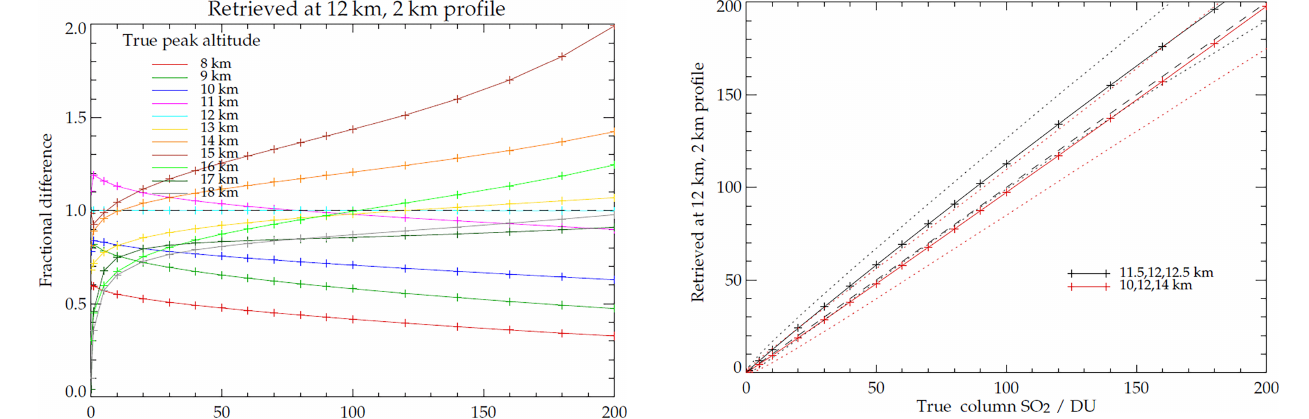
Figure 4. The black line indicates how columns from 0.1 to 200DU are retrieved on a fixed grid with a scalable triangular profile with base, mid-point and top at 11, 12 and 13km respectively, when the true profile shape is given by a triangular profile at 11.5, 12 and 12.5km, effectively overestimating the thickness of the plume. The red line shows the equivalent result for an underestimate of the plume thickness, the real profile given by 10, 12 and 14 km. The dotted lines show the bounds of retrieved error in each case. The dashed line is x = y , shown for